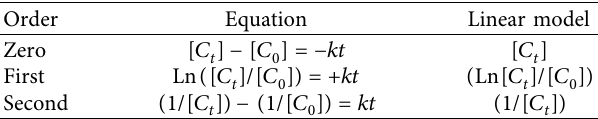
Table 3: Kinetics equations.